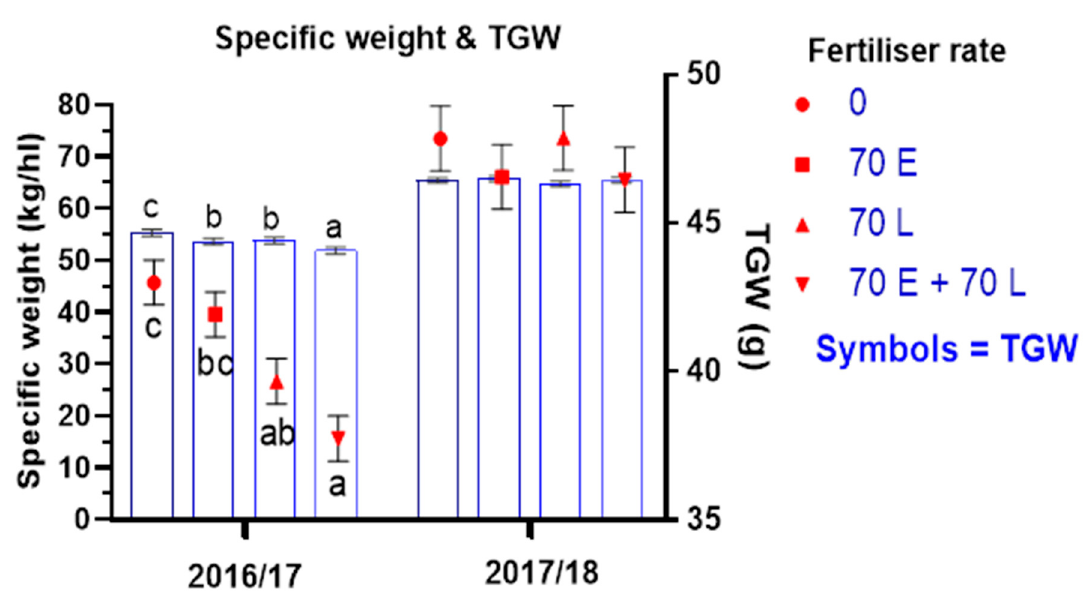
Figure 3. Specfic weight and thousand grain weight (TGW) with different rates and timings of nitrogen (kg/ha). Bars represent specific weight (kg/hl) which is kg/100 Litres. Symbols represent thousand grain weight (g) shown on the right Y -axis. Error bars represent standard error of the mean (SEM). Different letters denote statistical differences between treatments determined by Fisher’s protected LSD (0.05).